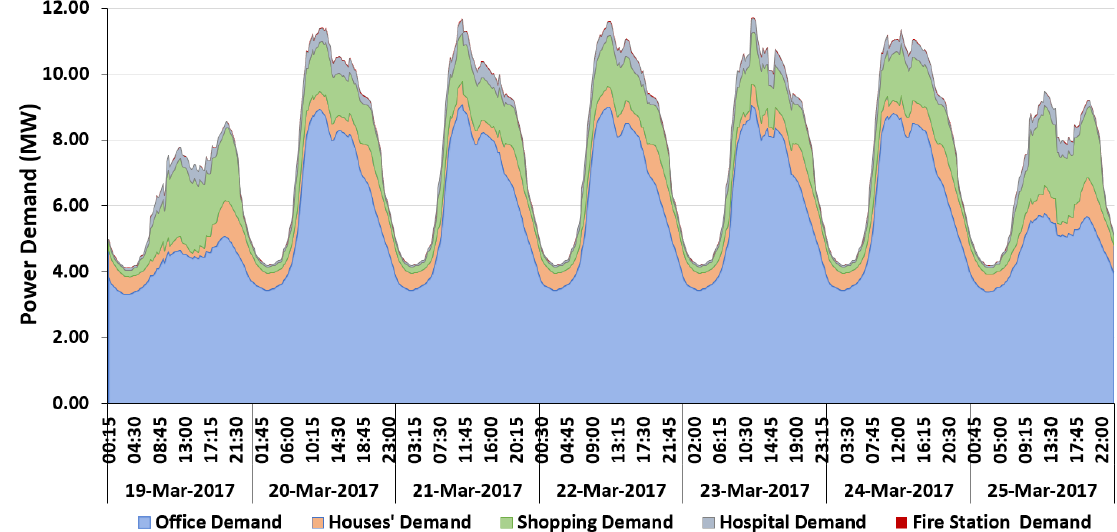
Figure 8. Power demand from office, residential, hospital, fire station, and shopping mall buildings.